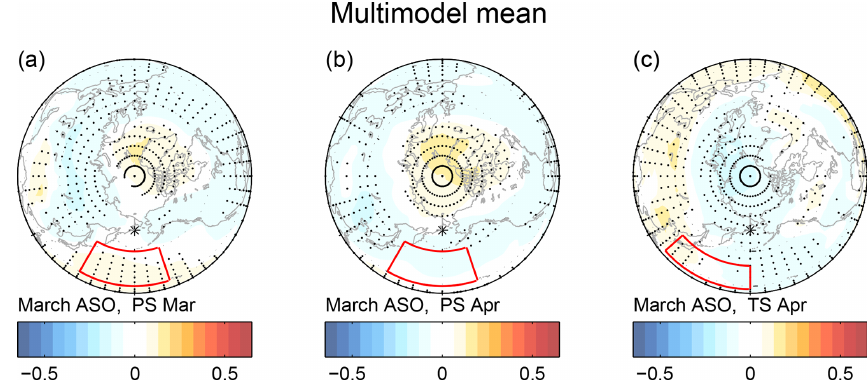
Figure 10. As in Fig. 6 but for the multimodel